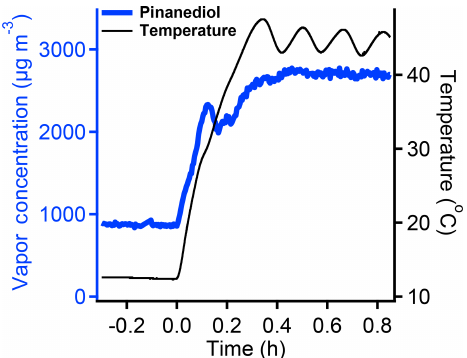
Figure 3. The increase in the pinanediol vapor concentration after increasing the chamber temperature from 13 to 44 ◦ C. The concen- tration of PD increased 2.5–3 times and reached a constant value after temperature stabilized at 44 ◦ C. The increase in the PD con- centration shows that PD can come out from the chamber walls at higher